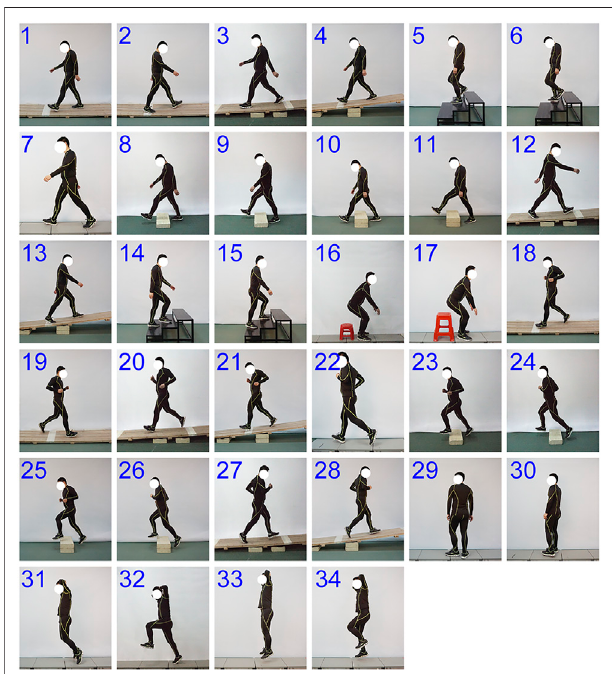
FIGURE 1 | Motor tasks explored in this study. Thirty-four motor tasks are analyzed in this study (Nos. 1 – 15: walking tasks, Nos. 16 and 17: sitting- down-standing-up tasks, Nos. 18 – 28: running tasks, Nos. 29 and 30: turning in place tasks, and Nos. 31 – 34: hopping tasks). Adapted from Huang et al.,